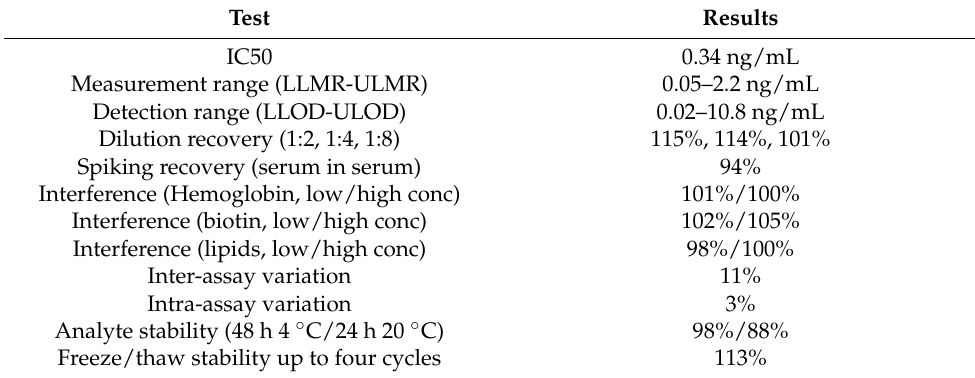
Table 2. Technical validation